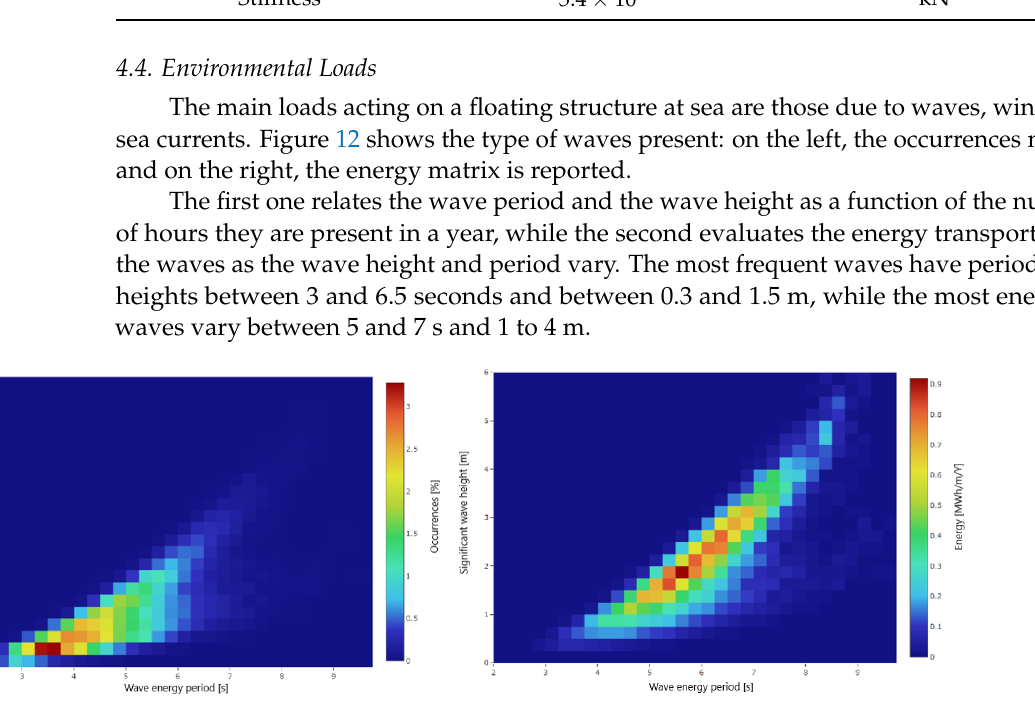
Figure 12. Occurrence matrix ( left ) and energy matrix ( right ) for Lampedusa.